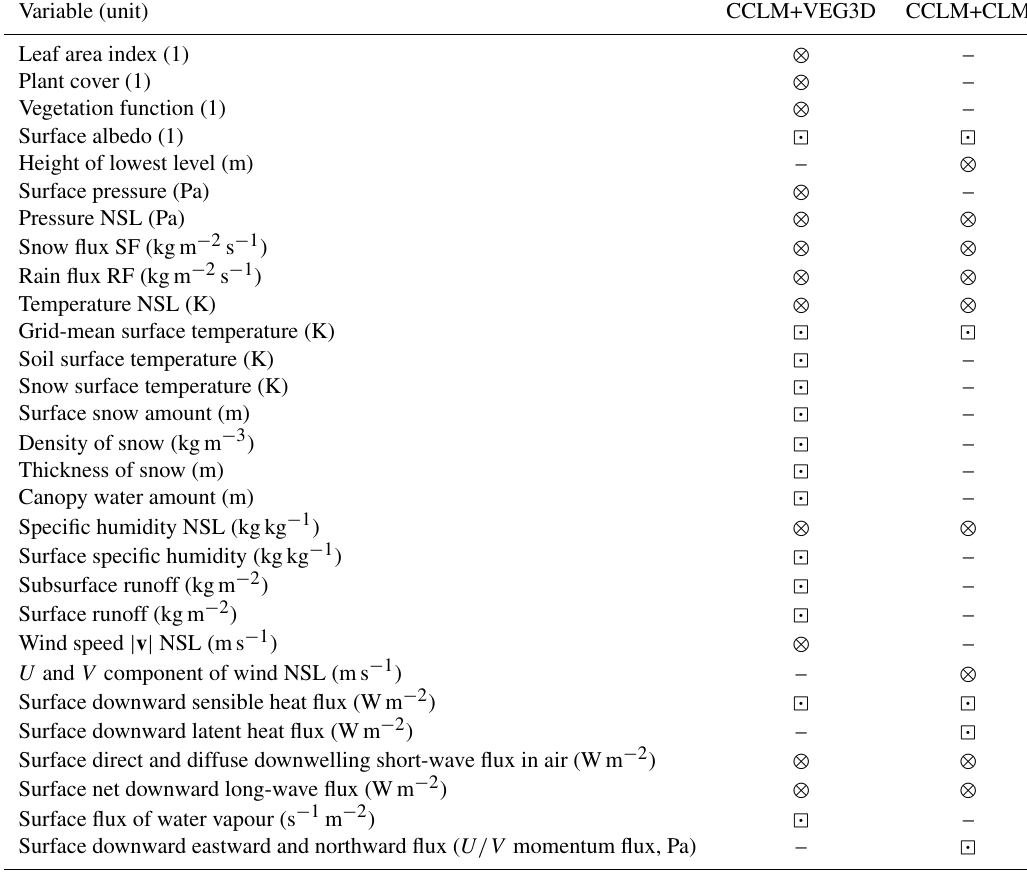
Surface downward eastward and northward flux ( U/V momentum flux, Pa) – NSL: lowest (near-surface) level of the 3-D variable RF: convective and large-scale rainfall flux; SF: convective and large-scale snowfall flux; SWD_S: surface diffuse and direct downwelling short-wave flux in air.